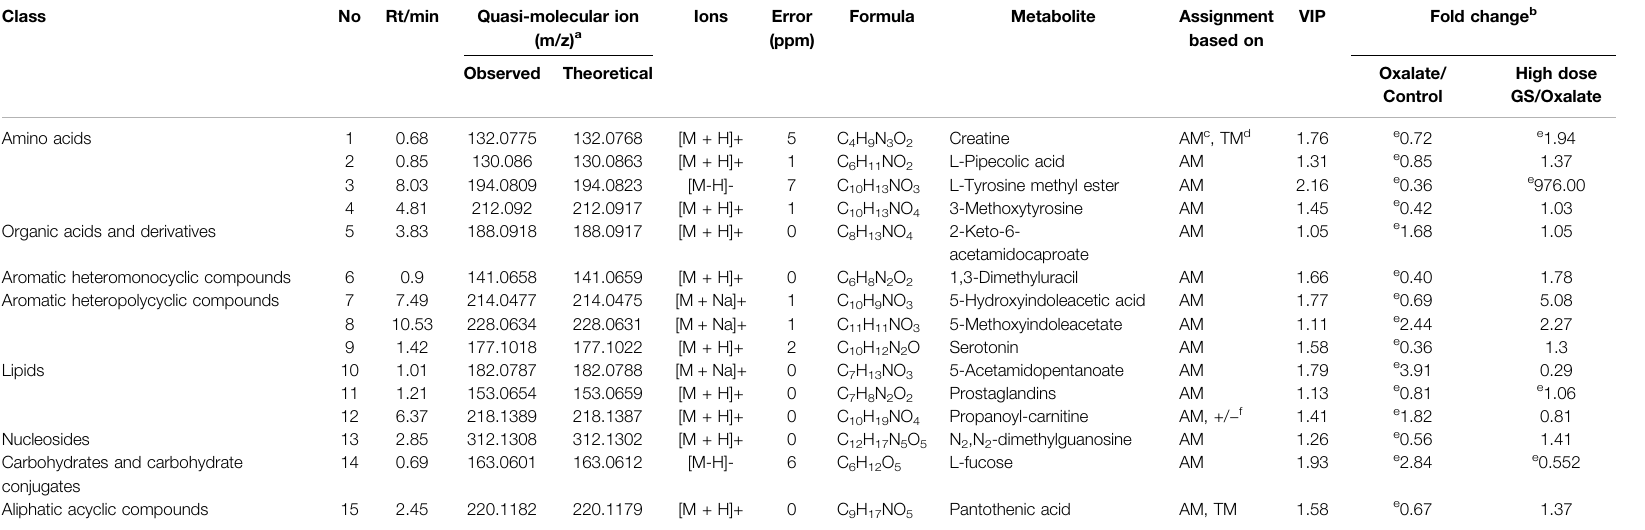
a Quasi-molecular ions (m/z) in this table include three species, namely, [M + H]+ or [M + Na]+ (ES + mode) and [M − H] − (ES − mode). b Statistical comparisons were performed using a Tukey post hoc test. c Accurate mass. d Tandem mass spectrometry. e p < 0.05. f ESI + and ESI − mode cross-assist